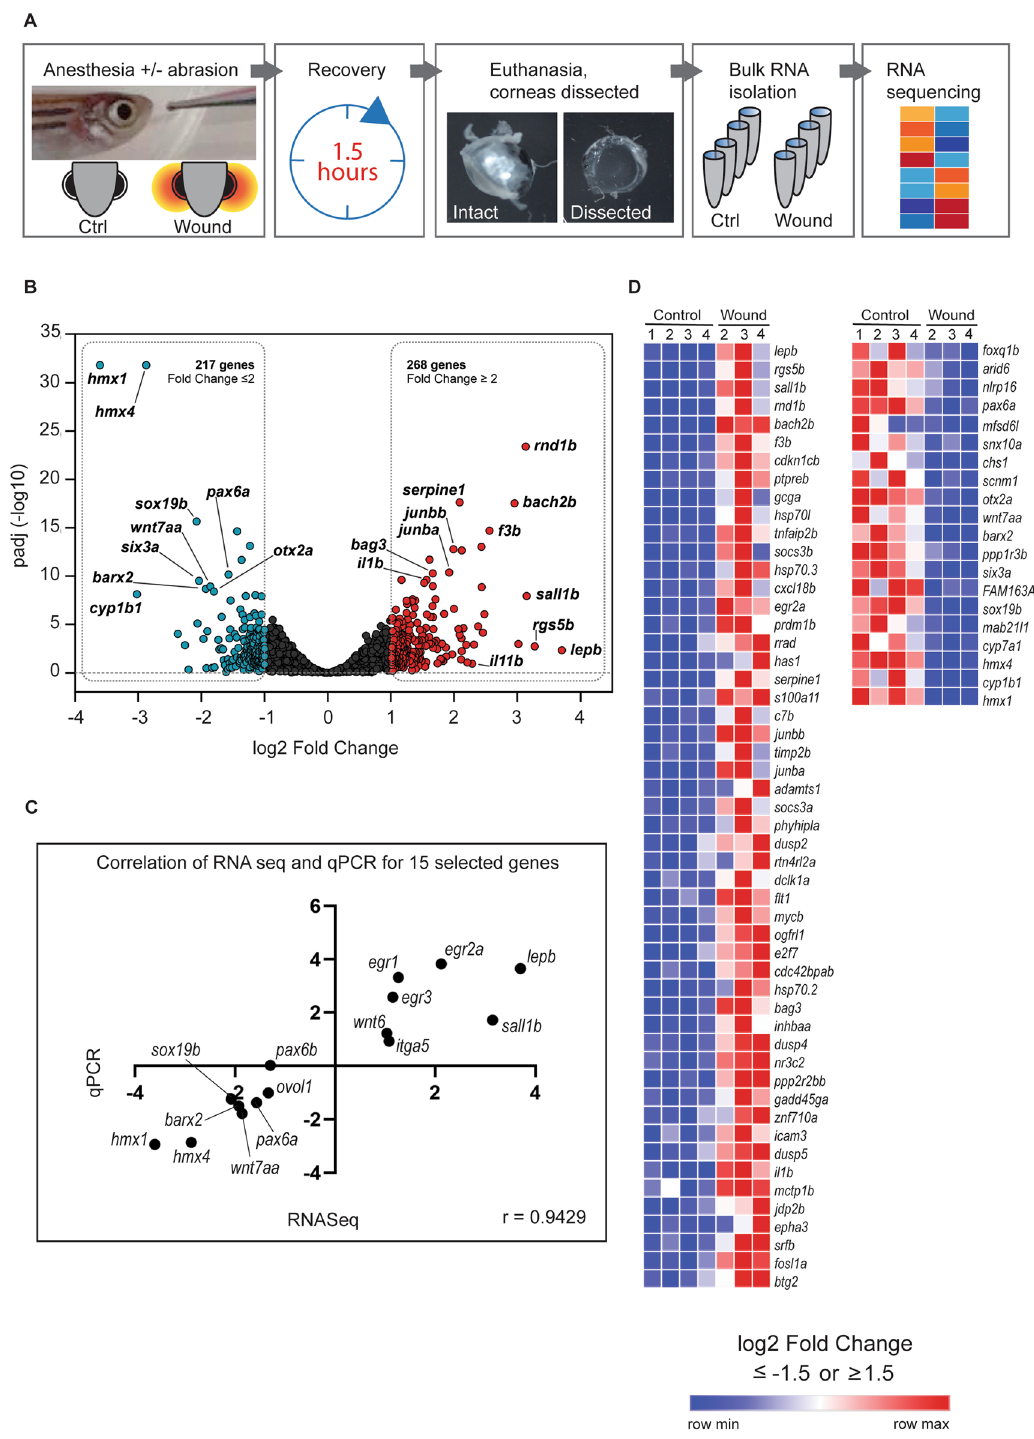
Figure 8. Transcriptomic changes during corneal wound closure. ( A ) Schematic presentation of the abrasion experiment, corneal collection and sample processing for RNA sequencing. ( B ) Volcano plot of gene expression changes (wounded vs. control samples) displays the up- and down-regulated genes at 1.5HPW. ( C ) Pearson correlation of RNA sequencing and qPCR results for selected 15 genes is used to validate the RNA-Sequencing results. ( D ) The heat map presents 52 most upregulated and 20 most downregulated genes (Log2 fold change ≥ 1.5 and ≤ − 1.5, p-adjusted ≤ 0.05). HPW: hours